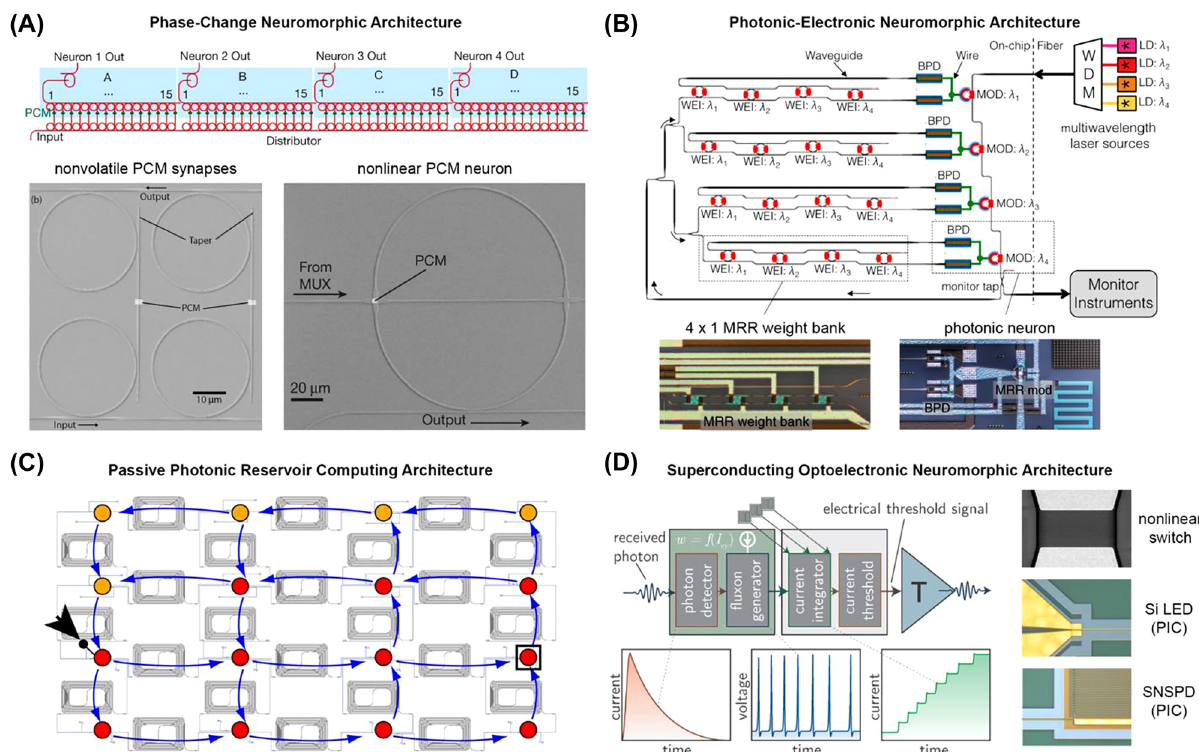
Figure 16: Photonic integrated neuromorphic computing architectures. (A) Neuromorphic architecture which exploits the nonvolatile and nonlinear nature of phase-change materials to implement both synaptic weights and neuron activation functions [147, 171]. (B) Foundry- compatible neuromorphic architecture which leverages optical – electrical – optical (O – E – O) conversion to implement fan-in and nonlinear activations. Add-drop microring resonator banks are used for synaptic weighting [182, 183]. (C) Fully passive photonic reservoir computing architecture using optical feedback and delay lines to implement fading short-term memory [184]. (D) Superconducting optoelectronic architecture for ultralow energy neuromorphic computing [185]. The superconducting nonlinear switch provides the voltage gain needed to drive silicon LEDs which are coupled to superconducting nanowire single photon detectors (SNSPD) via a photonic integrated circuit (PIC)